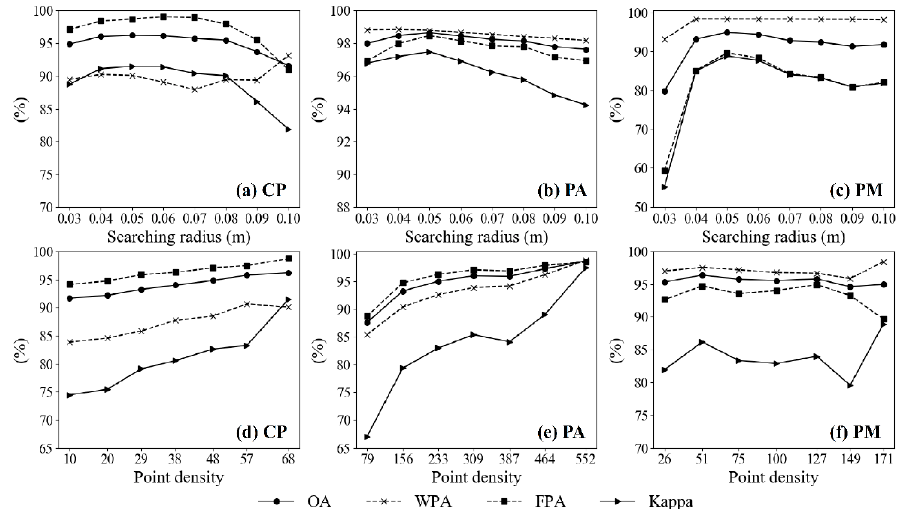
Figure 7. The subfigure ( a ), ( b ), and ( c ) show the classification accuracy of using different searching radii (from 0.03 m to 0.1 m with increment of 0.01 m) to extract features of local points in TLS data before running the FWCNN model. The subfigures ( d ), ( e ) and ( f ) show the classification accuracy of using the FWCNN model to distinguish TLS data with diverse point density (shown as the x-axis in these subfigures). Here, the point density means the number of points inside one sphere searching unit. The OA means the overall classification accuracy. The FPA and WPA means the producer’s accuracy of foliage and woody points after classification,